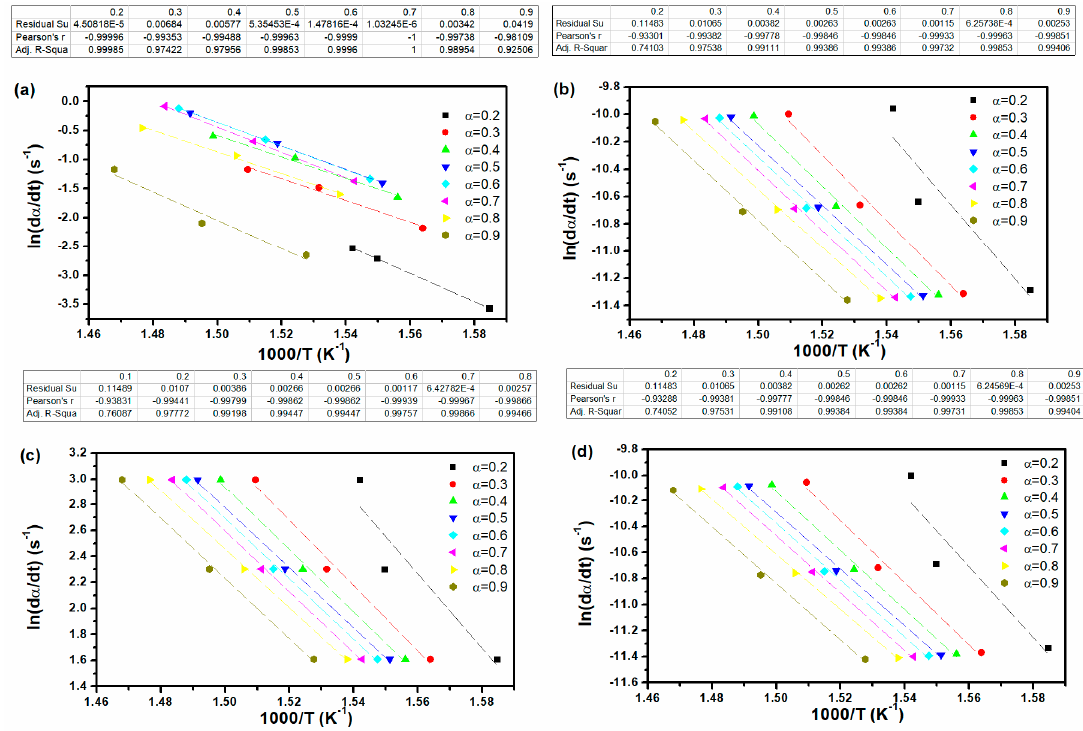
Figure 4. Typical iso-conversional plots for PU/Clay nanocomposites ( a ) Friedman , ( b ) KAS , ( c ) FWO , and ( d ) m-CR methods.